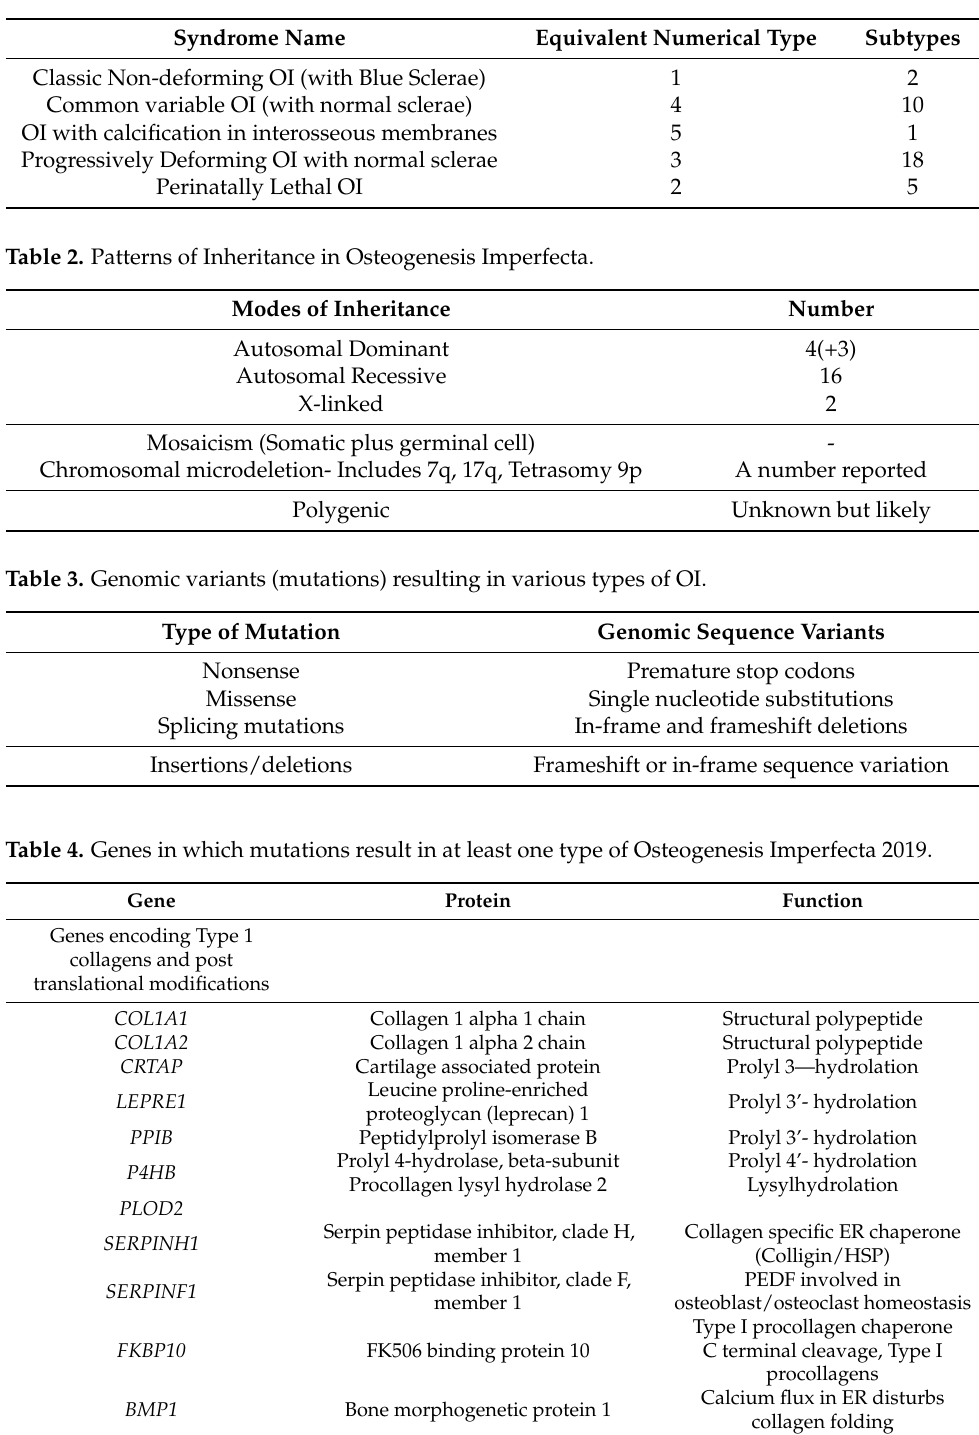
Table 1. The Osteogenesis Imperfecta (OI) Nomenclature 2015—International Nomenclature Com- mittee for Constitutional Disorders of the Skeleton (Updated January 2019).